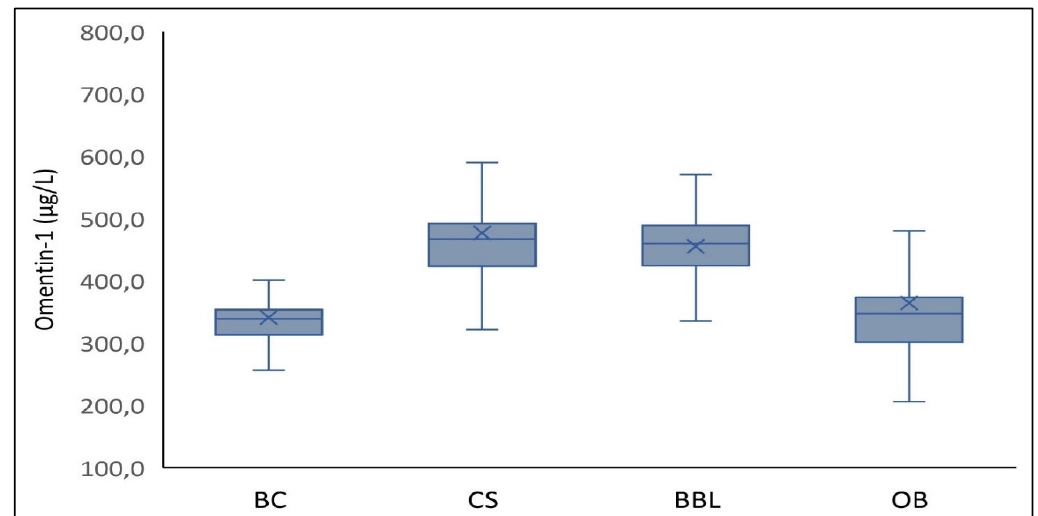
Figure 1. Circulating omentin-1 across study groups: In cases with postmenopausal breast cancer (BC) cases (N = 103), in healthy controls (CS, N = 103), in patients with benign breast lesions (BBL, N = 51), and in postmenopausal participants with obesity (OB, N = 50). Serum omentin-1 levels were significantly lower in BC cases (340.5 ± 109.3 μ g/L) than in the control subjects (476.7 ± 156.1 μ g/L, p < 0.001) and the patients with BBL (455.4 ± 65.9 μ g/L, p < 0.001), but were similar to the corresponding levels of participants with obesity (363.9 ± 104.4 μ g/L, p = 0.21).